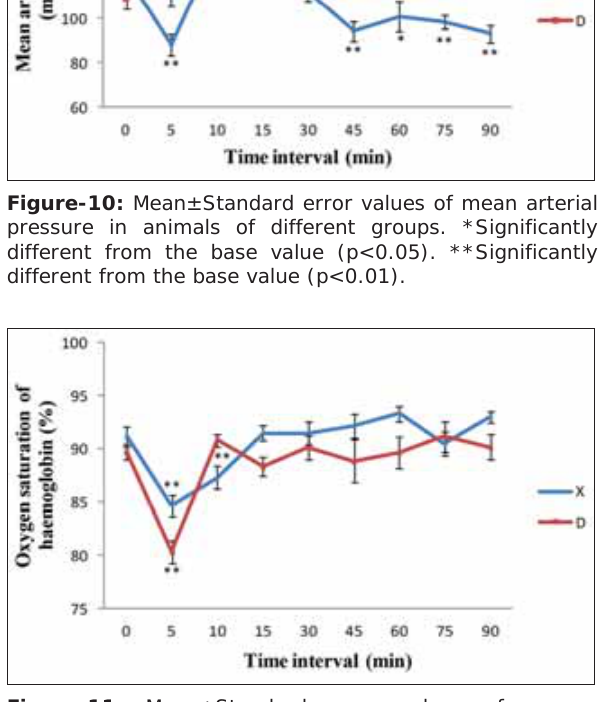
Figure-11: Mean±Standard error values of oxygen saturation of haemoglobin in animals of different groups. *Significantly different from the base value (p<0.05). **Significantly different from the base value